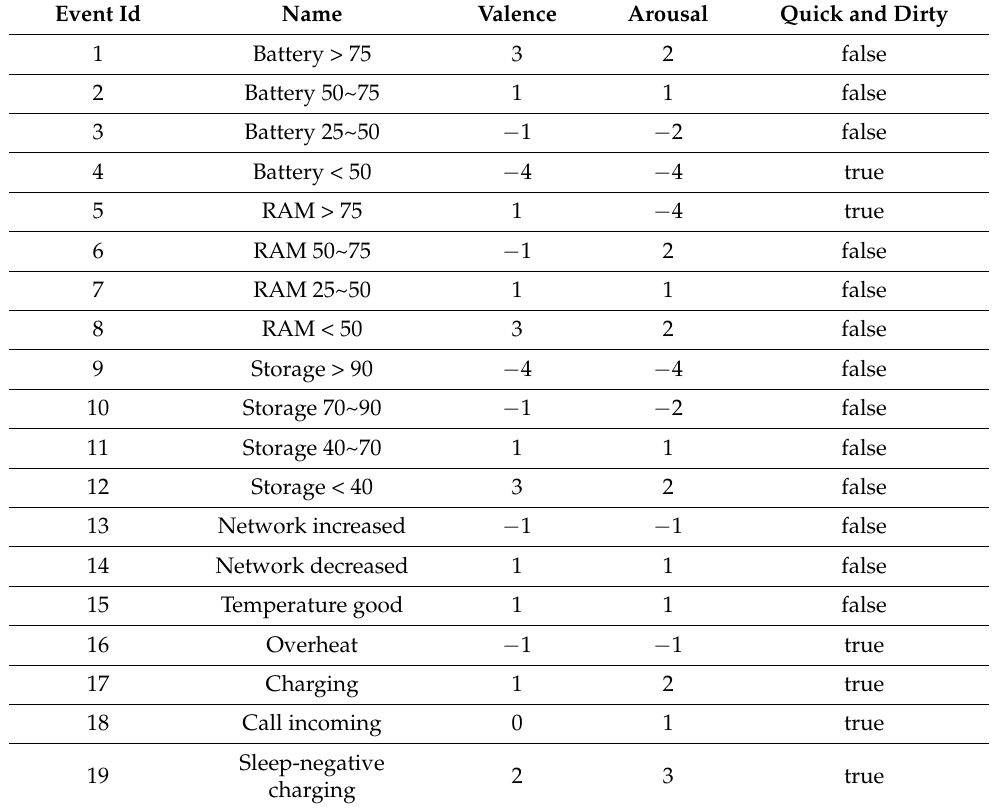
Table 2. Emotional event